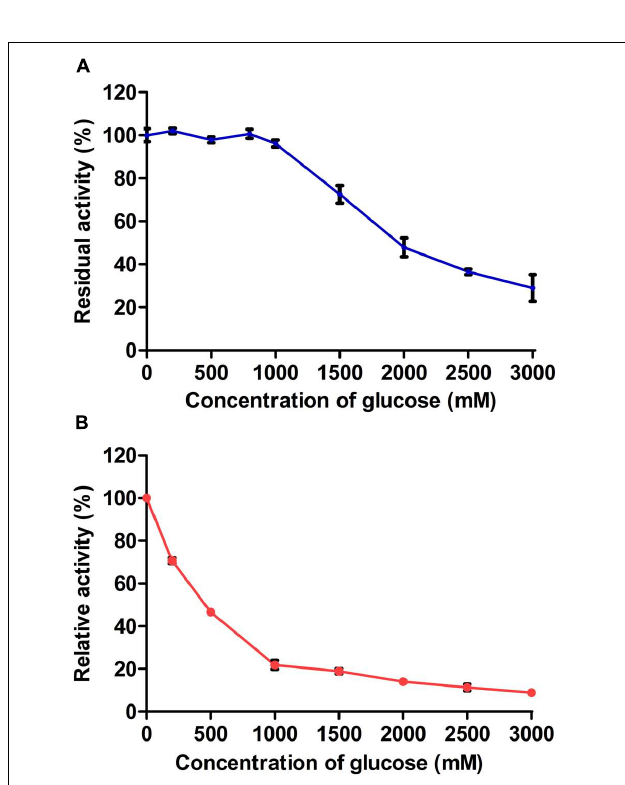
( Figure 5A ). Within 2 h, AaBGL1 and AaBGL2 were stable below